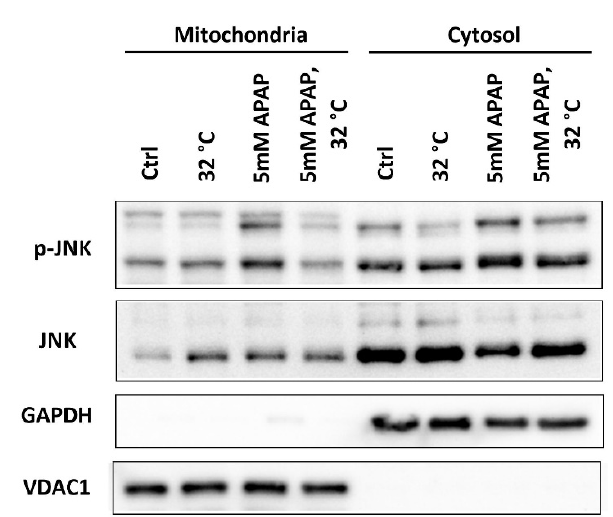
Figure 5. Effect of moderate hypothermia (32 °C) on the activation of the c-Jun N-terminal kinase (JNK) signaling pathway in TAMH. Western blotting was performed to examine the protein expressions of phosphorylated-JNK (p-JNK) and JNK in the mitochondrial and cytosolic fractions. GAPDH and VDAC1 were used as the housekeeping protein for the cytosolic and mitochondrial fractions respectively.